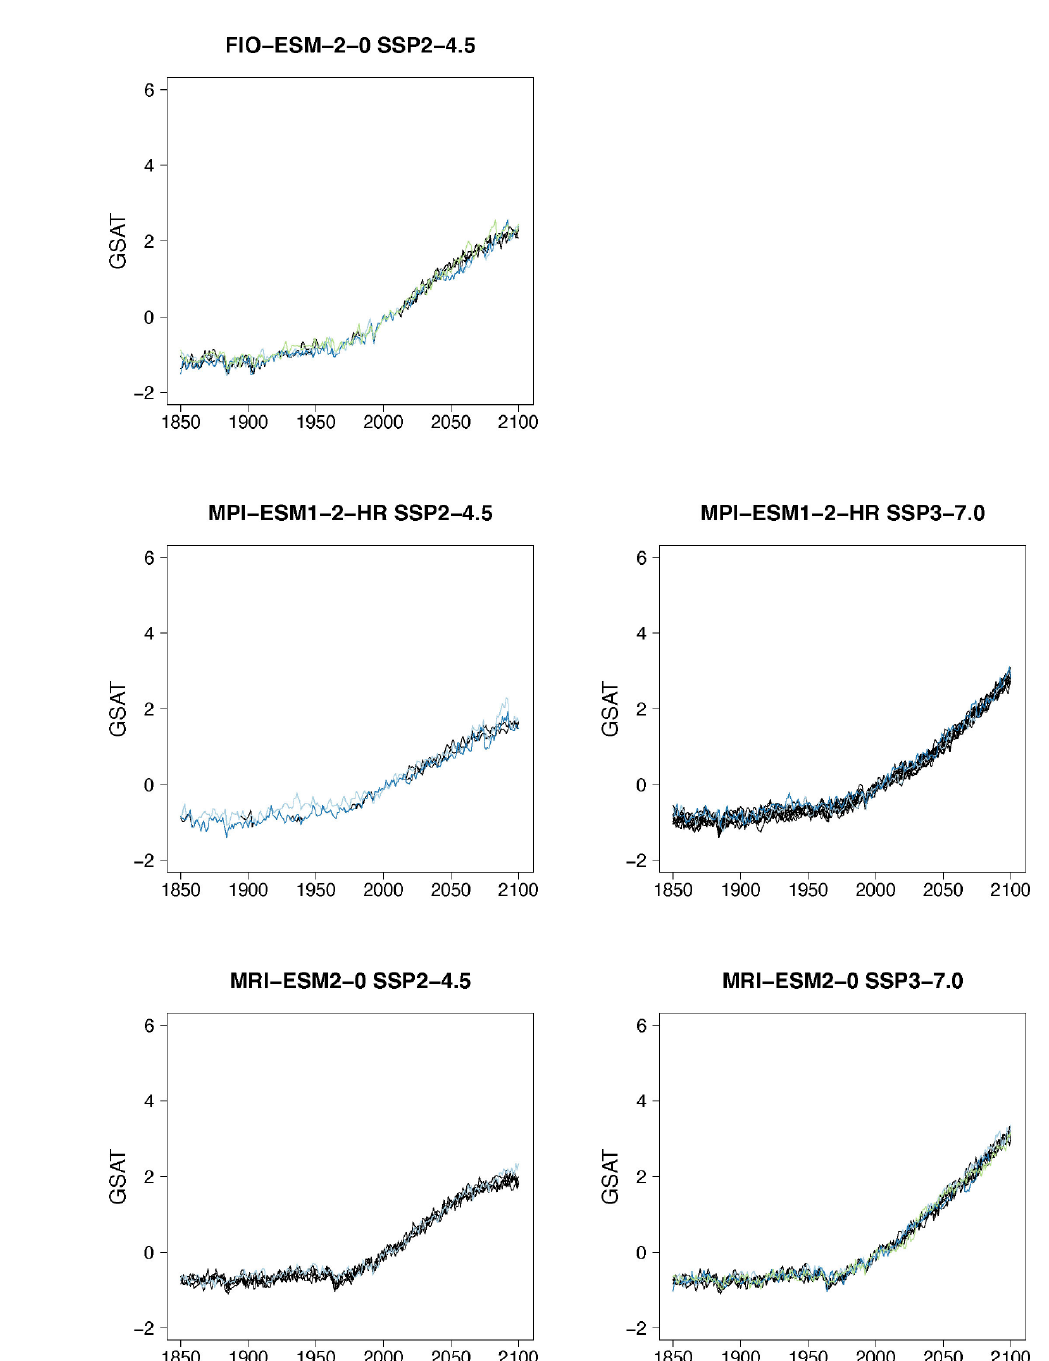
Figure B4. Examples of target (black lines) and stitched (colored) GSAT time series for ESMs in the PANGEO archive that ran at least one trajectory along the Tier 1 experiments of ScenarioMIP (SSP1-2.6, SSP2-4.5, SSP3-7.0, SSP5-8.5). We use the two bracketing scenarios and emulate trajectories that follow the two intermediate